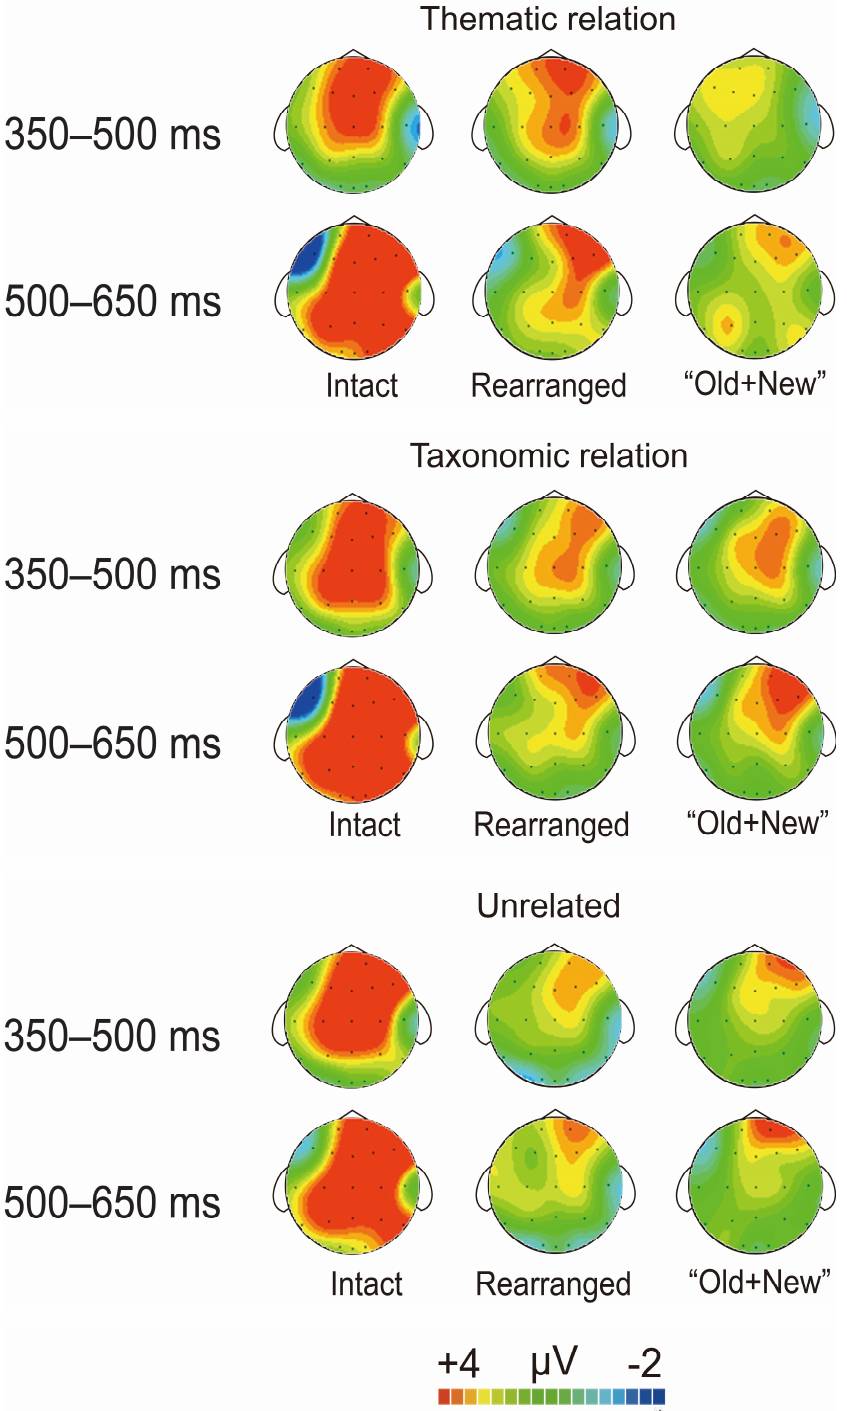
Figure 5. The topographical maps over the entire scalp extracted from difference waveforms between correctly rejected new pairs and correctly identified intact, rearranged, and “old + new” pairs, are shown within the latency windows of interest.